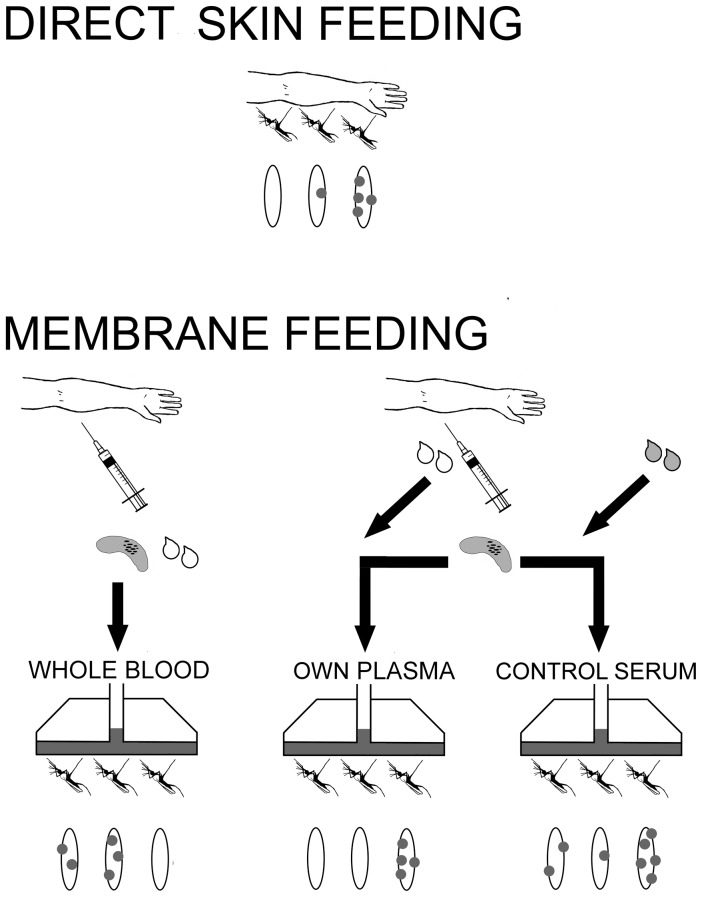
Mosquito feeding assays.In direct skin feeding assays, mosquitoes are placed directly on the skin of a parasitaemic host. In direct membrane feeding assays, a venous or finger prick blood sample from a naturally infected individual is offered to mosquitoes. Water-jacketed glass feeders are kept at approximately 37°C and mosquitoes feed through a membrane. In a whole blood assay, the blood sample is offered to mosquitoes directly. In a serum replacement experiment, the blood cells are offered to mosquitoes in a paired experiment in the presence of own plasma or of control serum.